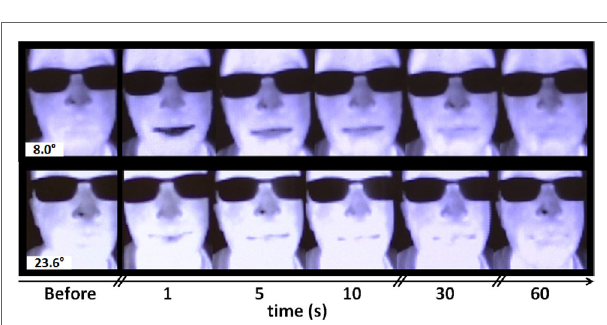
FigUre 8 | Cooling lips after drinking cool and room-temperature water. Consent has been obtained from the individual depicted (the first author) for the publication of this